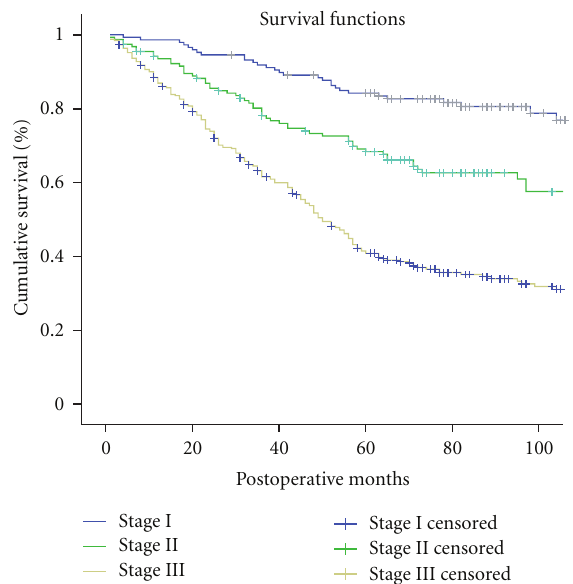
Figure 1: Cumulative survival curves for patients undergoing curative distal gastrectomy according to the 7th edition of the UICC TNM classification. There was significant di ff erence between the subgroups ( P < 0 .